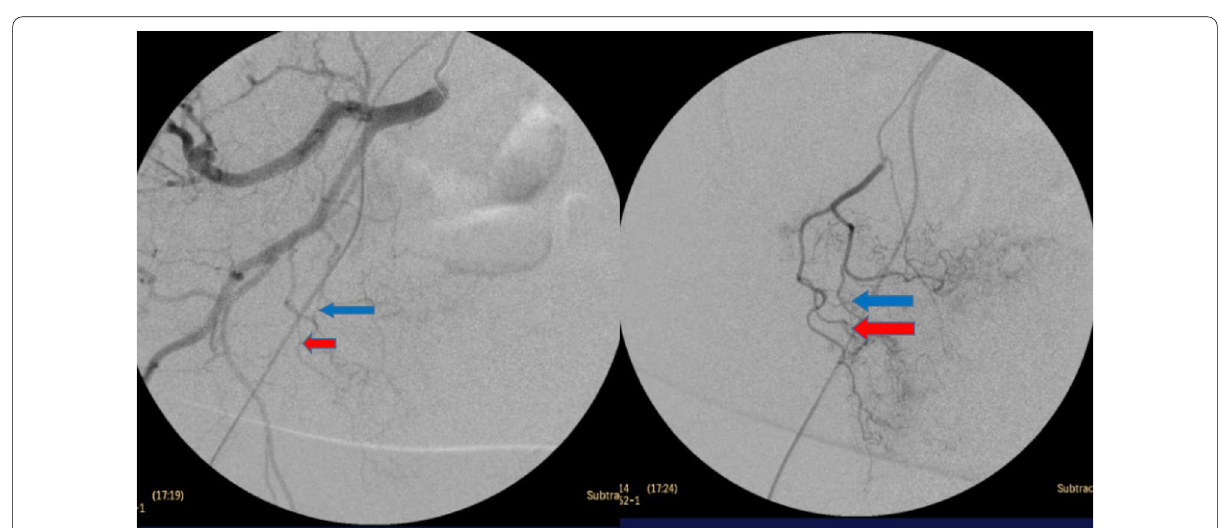
Fig. 2 Angiography images, showing double prostatic arteries for right side, common origin with superior vesical artery (blue arrow) and separate origin of superior vesical artery (red